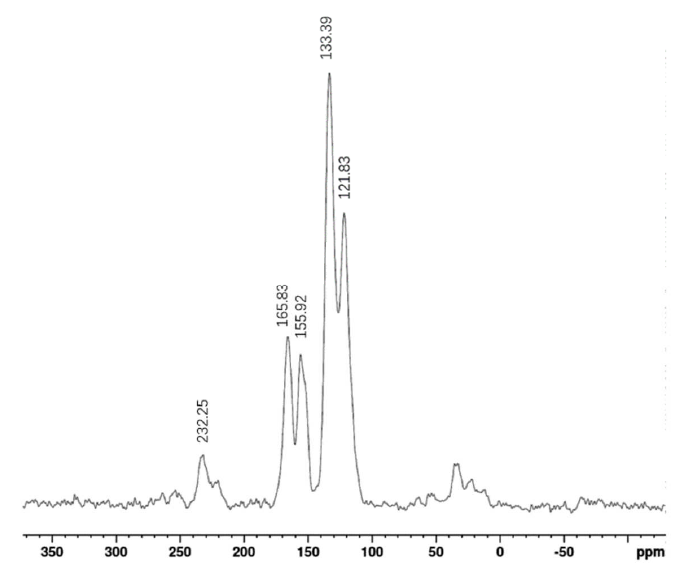
Figure 1. CP-MAS 13 C NMR spectra of AEPOP.